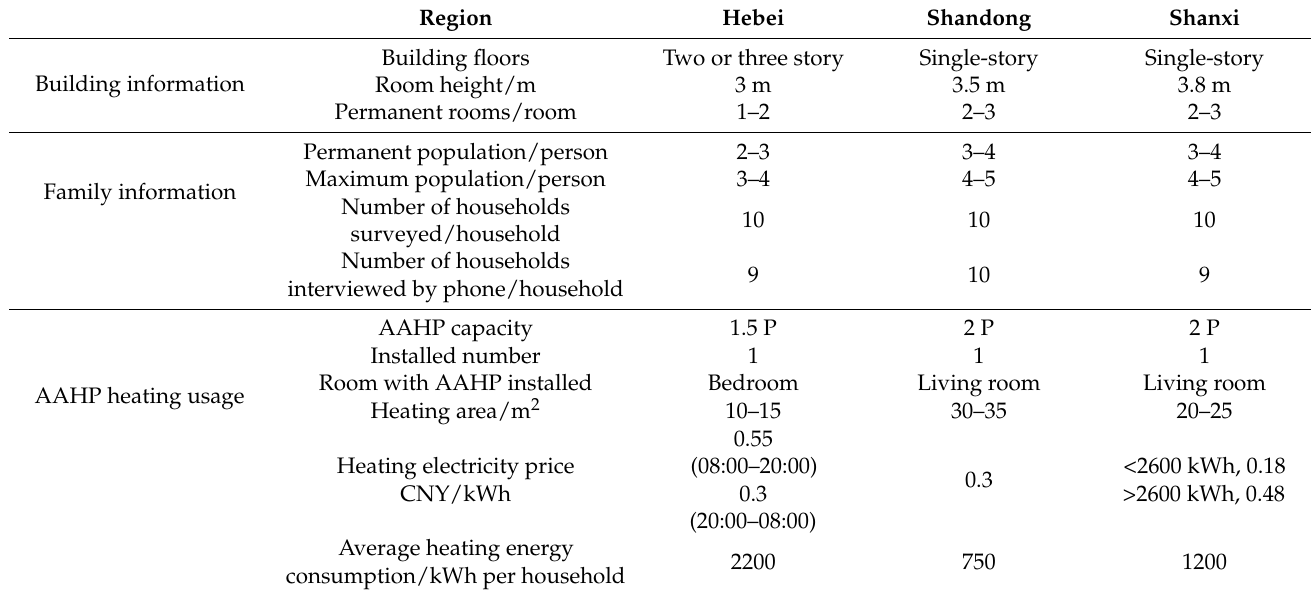
Table 2. Building information, family information, and AAHP heating usage in three different regions in northern